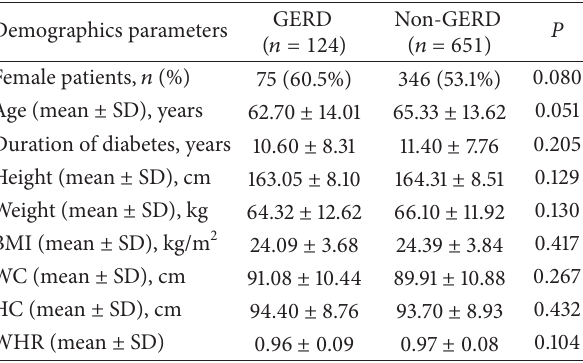
Table 1: Baseline characteristics of GERD group and non-GERD group.